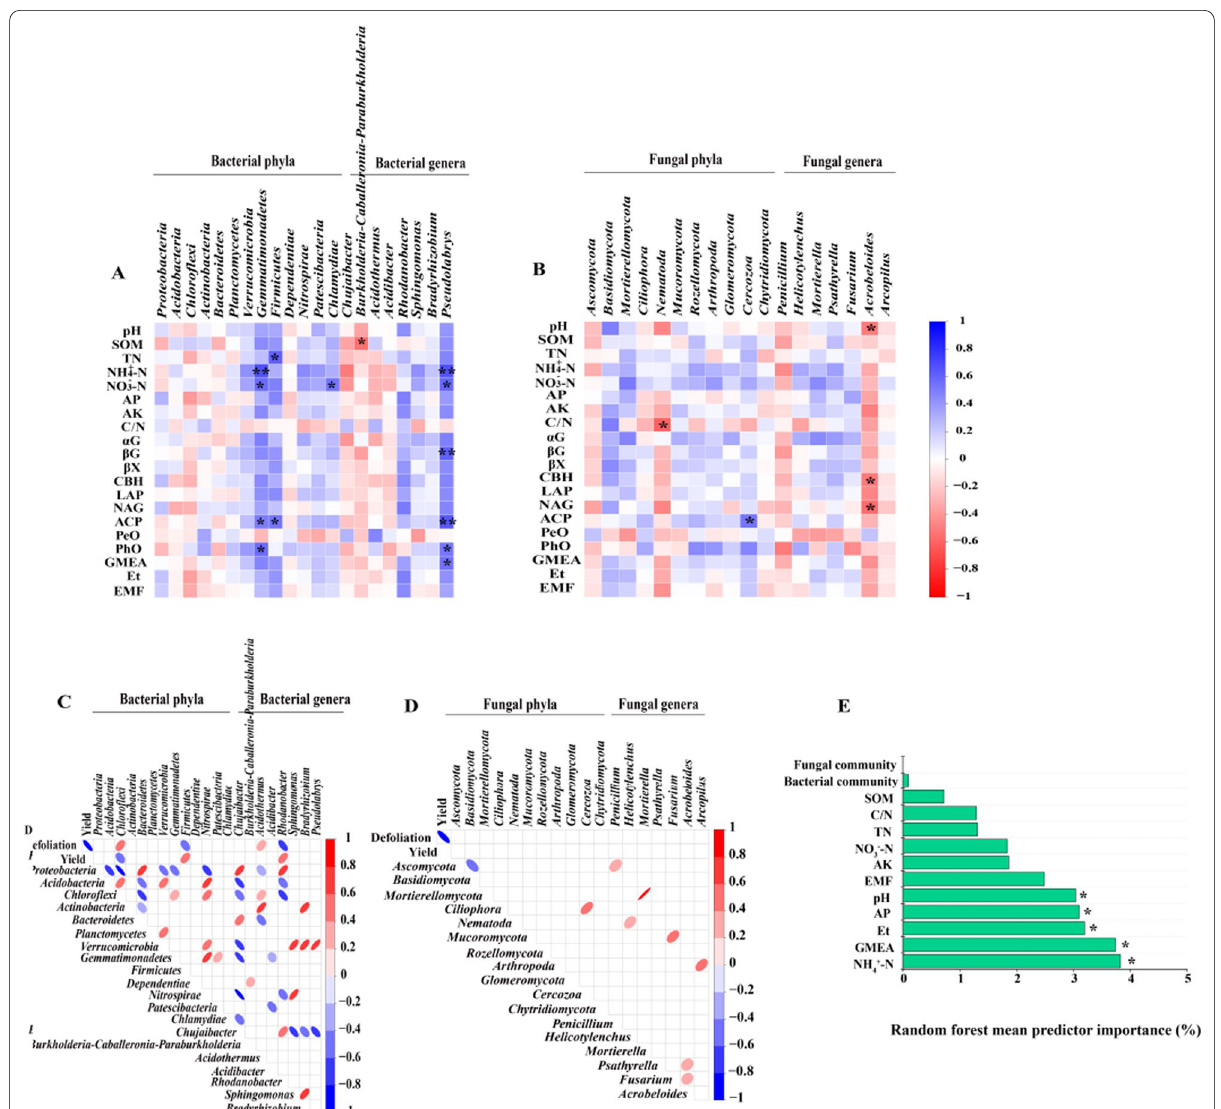
Fig. 6 Spearman’s correlation coefficients between soil physicochemical properties, enzyme activity, defoliation rate and the 15-dominant bacterial ( A , C ) and fungal taxa ( B , D ) of 2018–2019. Random forest mean predictor importance (% increase in MSE) of the soil physicochemical properties, microbial enzyme activities, and bacterial and fungal communities (NMDS1) with respect to early defoliation rate across all treatments ( E ). One and two asterisks represent significance at P < 0.05 and P < 0.01, respectively. Shades of blue and red represent a negative and positive correlation coefficient (r), respectively. Empty grids mean no difference. Significance levels of each predictor are as follows: *p < 0.05 and **p <